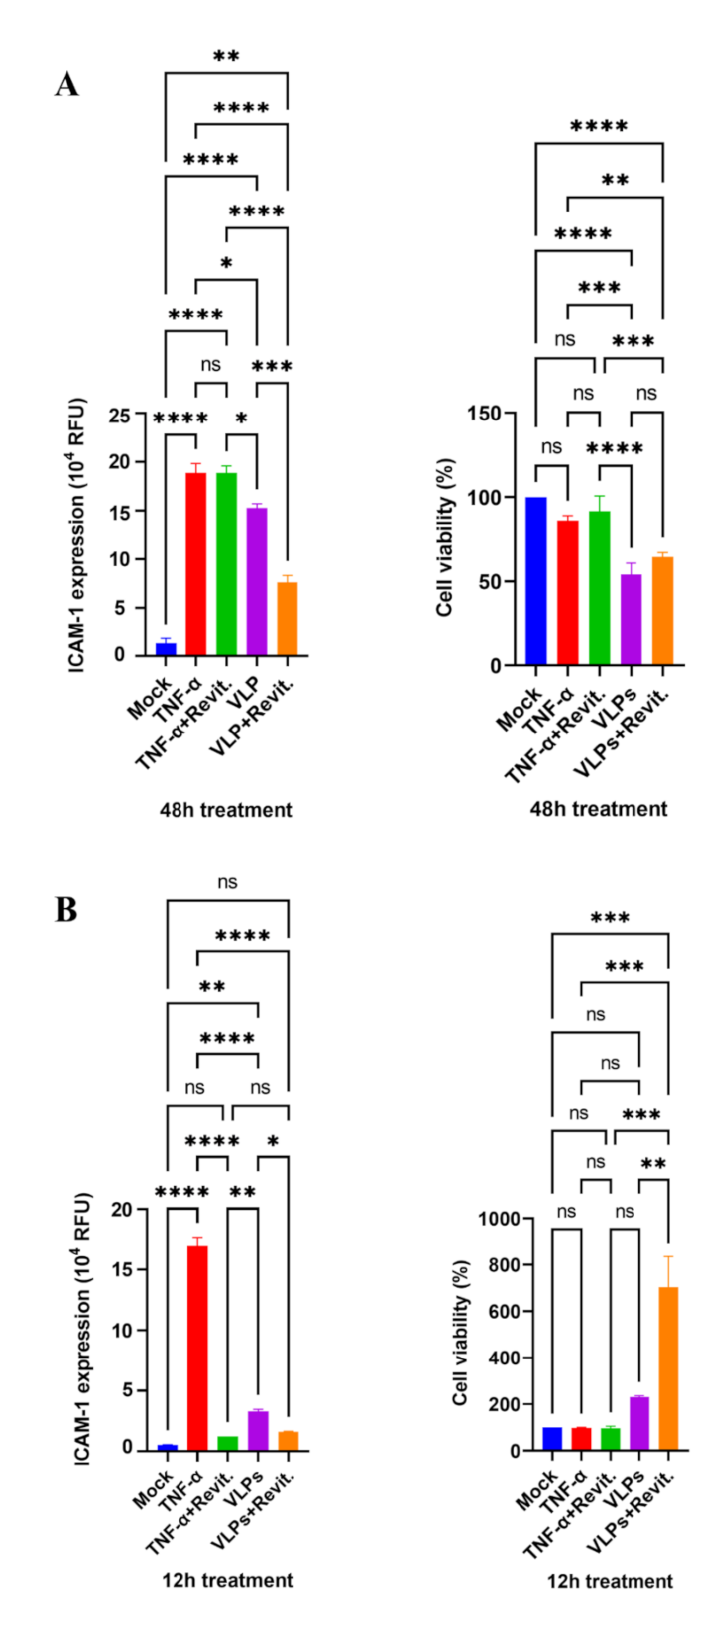
Figure 5. Effect of RevitaCell on VLPs- and TNF- α -induced ICAM-1 upregulation. ( A ) ECs were pre-treated for 1 h with RevitaCell (1 × ) and then treated with VLPs (10 × ) or TNF- α (10